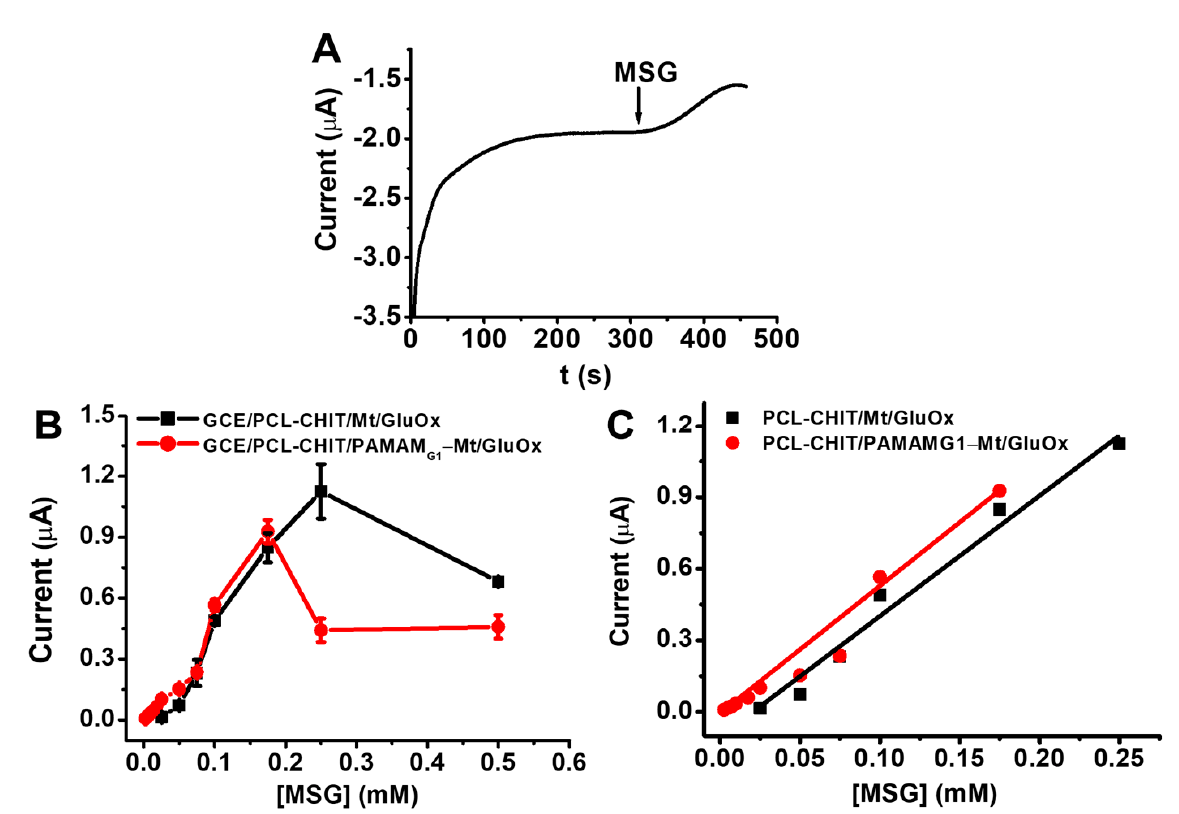
Figure 7. ( A ) Current change with the addition of MSG into the working buffer. ( B ) Responses of the GCE/PCL–CHIT/Mt/GluO x and GCE/PCL–CHIT/PAMAM G1 –Mt/GluO x biosensors to various MSG concentrations. ( C ) Calibration graph of both biosensor systems (in 50 mM sodium phosphate buffer, pH 7.5 for GCE/PCL–CHIT/Mt/GluO x and pH 6.5 for GCE/PCL–CHIT/PAMAM G1 – Mt/GluO x , at − 0.7 V; error bars show the SDs of three measurements). Table 1. A comparison of the performances of GluO x -based electrochemical biosensors in the liter- ature.